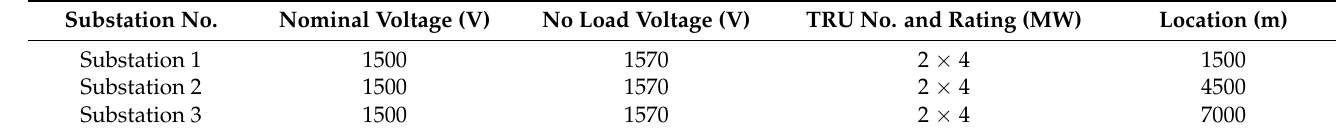
Table 8. Substation input parameters.